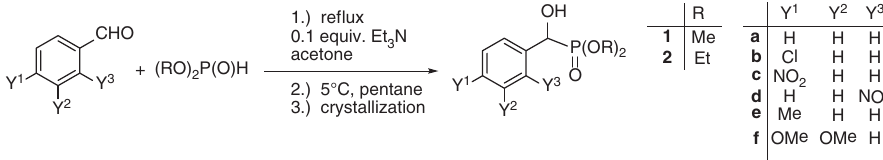
Scheme 2: Our method for the preparation of α -hydroxyphosphonates described in this